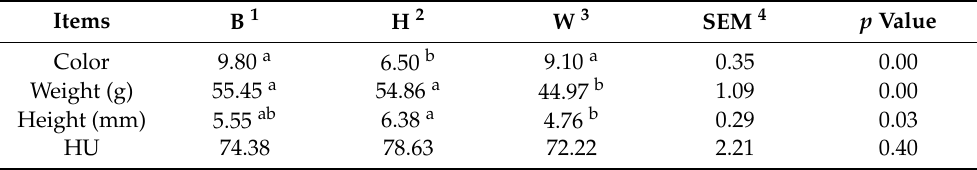
Table 2. Egg quality for three breeds of